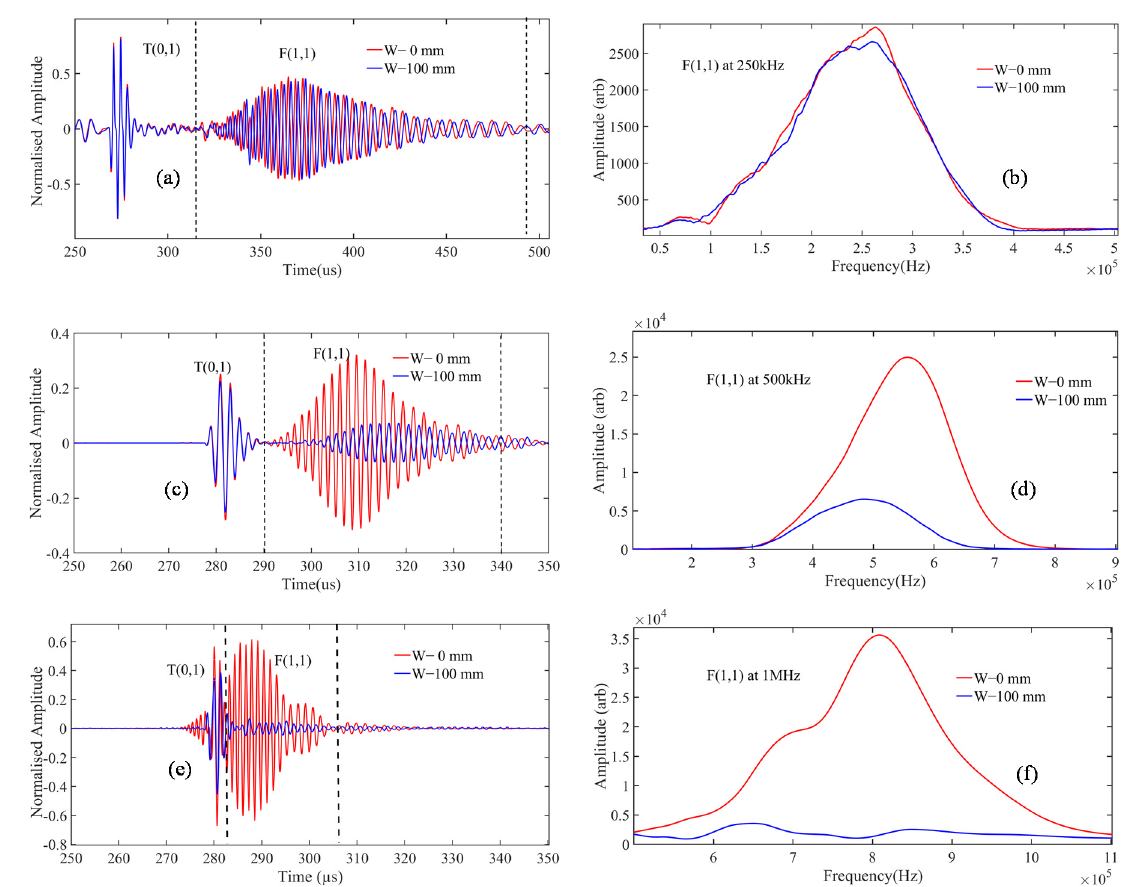
Figure 8. Obtained A-Scan signal at 0 cm and 10 cm fluid loading at the frequencies of ( a ) 250 kHz, ( c ) 500 kHz, and ( e ) 1000 kHz and their corresponding FFT plots at ( b ) 250 kHz, ( d ) 500 kHz, and ( f ) 1000 kHz.